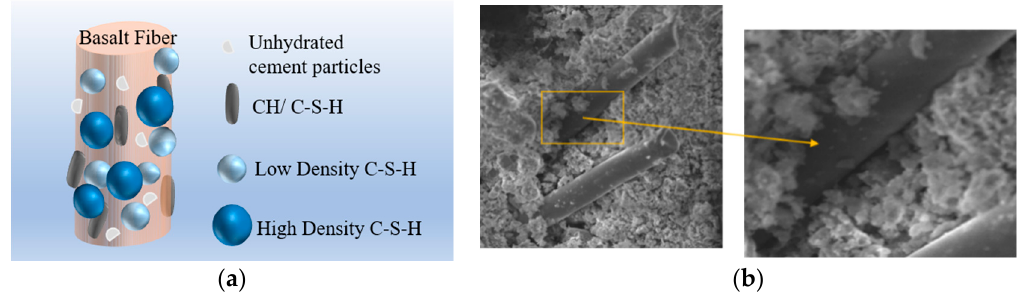
Figure 8. Diagram of BF-concrete interface. ( a ) Schematic of BF-concrete interface; ( b ) Image of BF-concrete interface.